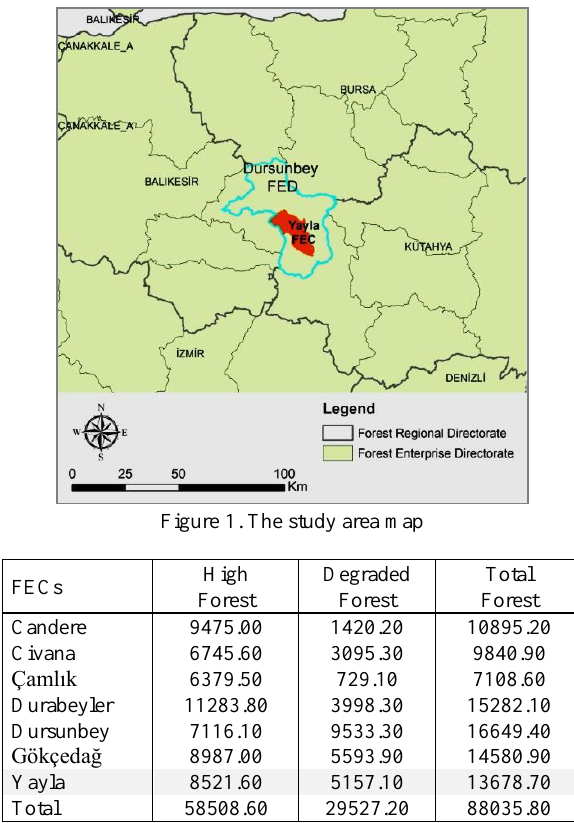
Table 1.Forest resources in Dursunbey FED (ha) (URL-1)